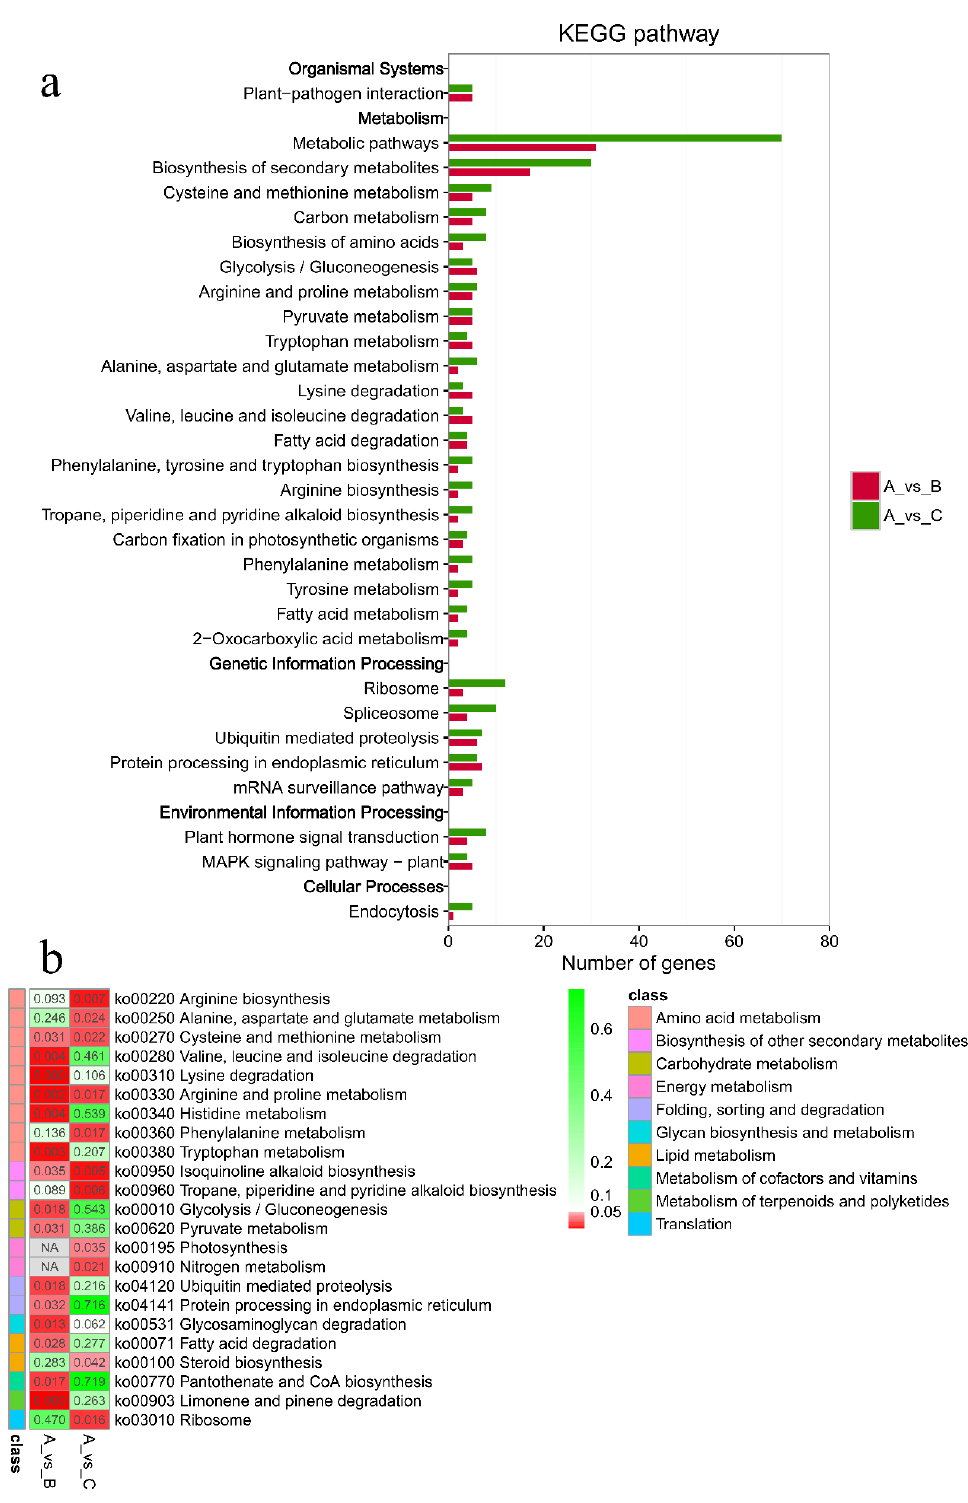
Figure 7. KEGG enrichment analysis of selected genes. ( a ) Hot map for significance of pathway. ( b ) Number of genes for pathway. A, P. neoveitchii ; B, P. wilsonii ; C, P. likiangensis . P. likiangensis was subjected to selective sweep analysis in comparison with the back- ground group of P. neoveitchii , with the criteria being F st (C) ≥ 0.81 and π (C) ≤ 2.75 × 10 − 5 ( − lg π (C) ≥ 4.56) (Figure 5). GO enrichment analysis (Figure 6; Table S4) and pathway anal- ysis (Figure 7) of the selected genes revealed that their molecular functions were mainly